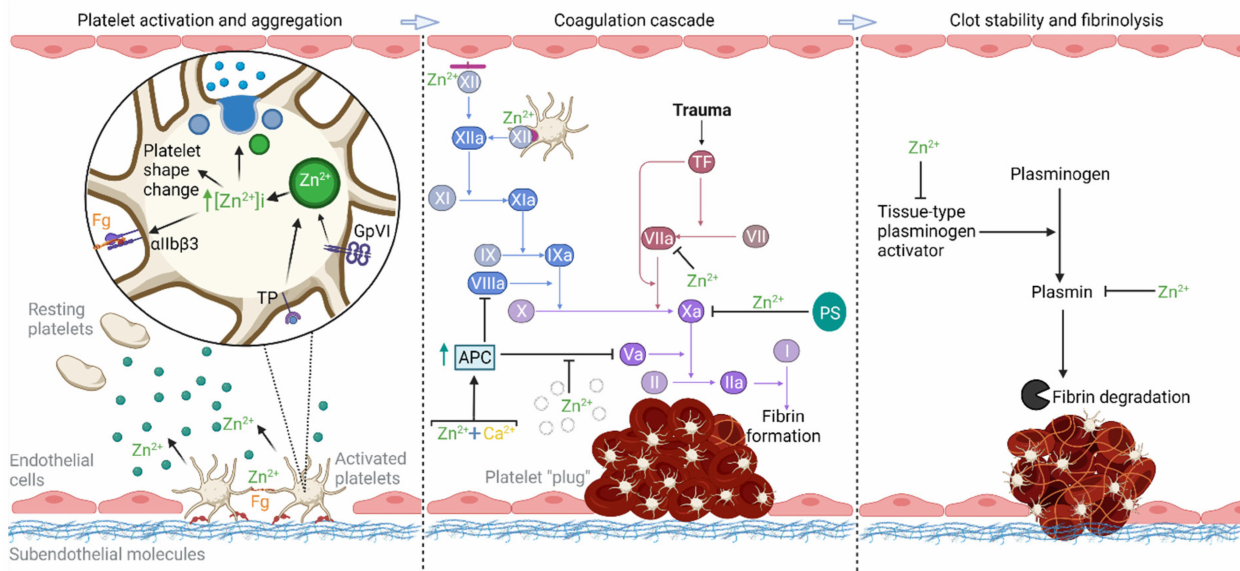
Figure 1. The role of Zn 2+ in hemostasis. Zn 2+ is an important mediator of hemostasis, affecting several key aspects of the process. Platelet activation and aggregation: Platelets bind to exposed subendothelial molecules and deposited von Willebrand factor. When collagen and thromboxane A2 bind to platelet receptors, glycoprotein (GP) VI and thromboxane receptor (TP), respectively, it is likely that a cytosolic increase in Zn 2+ results, from α -granules, leading to platelet shape change, granule release, and activation of α IIb β 3. Platelets bind fibrinogen (fg) through their activated α IIb β 3 integrin to aggregate, a process enhanced by Zn 2+ . Granule release causes increases in extracellular Zn 2+ , potentiating and activating nearby platelets. Coagulation cascade: Zn 2+ can directly or indirectly modulate the activity of several coagulation factors. Pro-coagulant effects by Zn 2+ include the facilitation of the intrinsic pathway through enabling FXII binding to platelet and endothelial surfaces and, in the presence of phospholipid vesicles, attenuating the inhibitory action of activated protein C (APC) on FVa. Anti-coagulant effects by Zn 2+ include the direct inhibition of FXa production through FVIIa binding, increased binding of protein S to FXa (attenuating its activity) and, in the presence of Ca 2+ , promotion of APC generation. The coagulation cascade is highlighted in blue, red and purple to illustrate the intrinsic, extrinsic and common pathways respectively. Clot stability and fibrinolysis: Zn 2+ promotes thrombus longevity by attenuating components of the fibrinolytic system. Created with BioRender.com (accessed 27 August